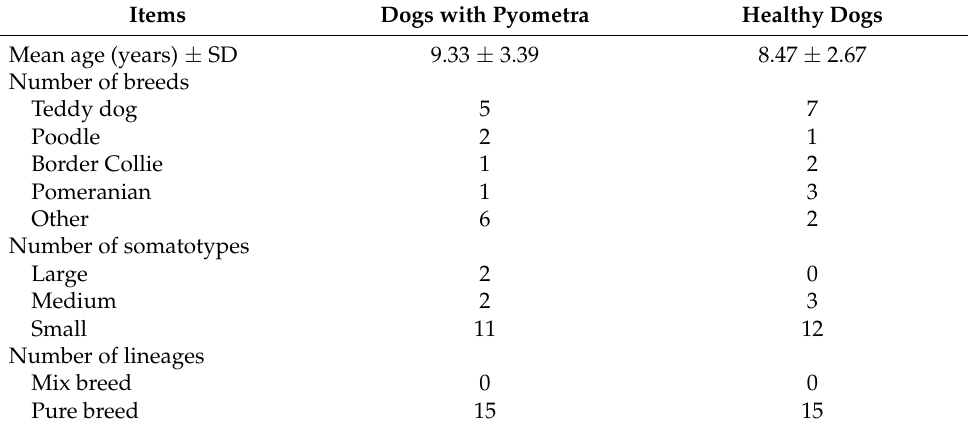
Table 1. The clinical information of healthy dogs and diseased dogs with